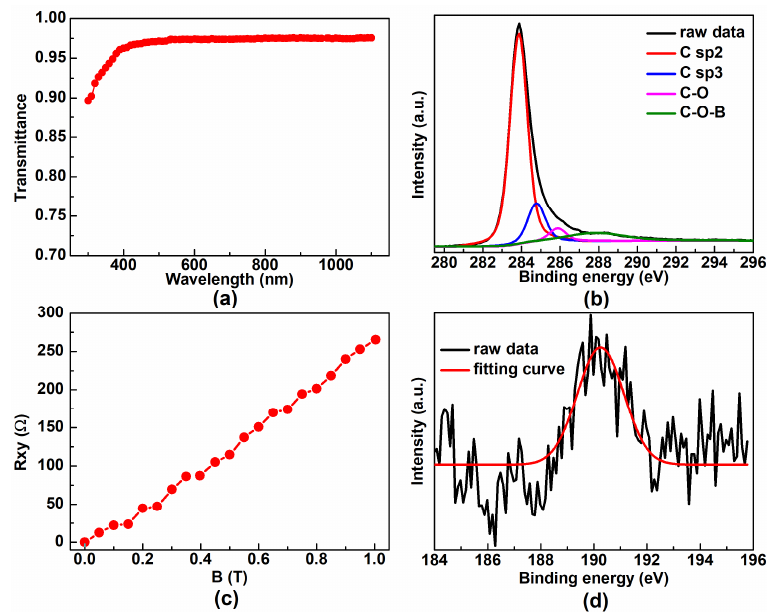
Figure 3. The transmittance ( a ) and Hall resistance ( c ) of the boron-doped graphene grown on the electropolished copper foil. The XPS spectra of C1s ( b ) and B1s ( d ) of the boron-doped graphene grown on the electropolished copper foil.